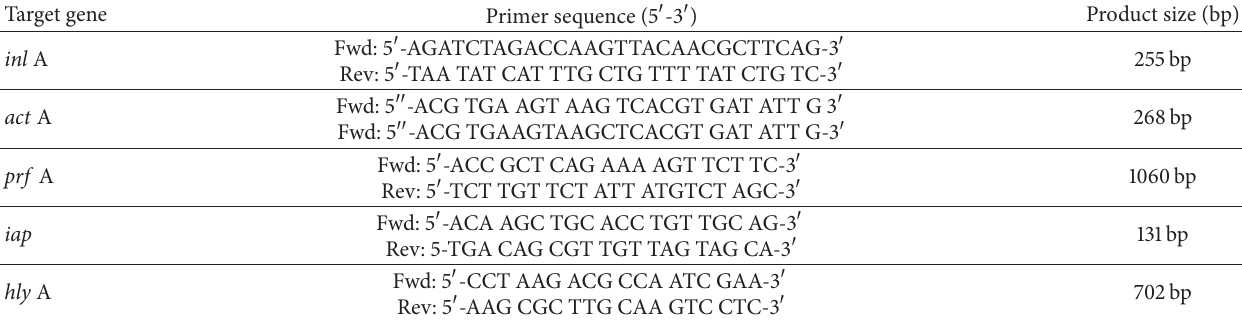
Table 2: Primer sequences used for the amplification of virulence-associated genes of Listeria monocytogenes .